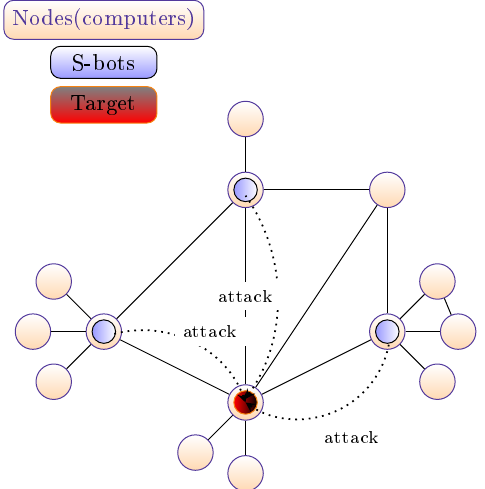
Fig. 2: Particles coordinated attack on http server